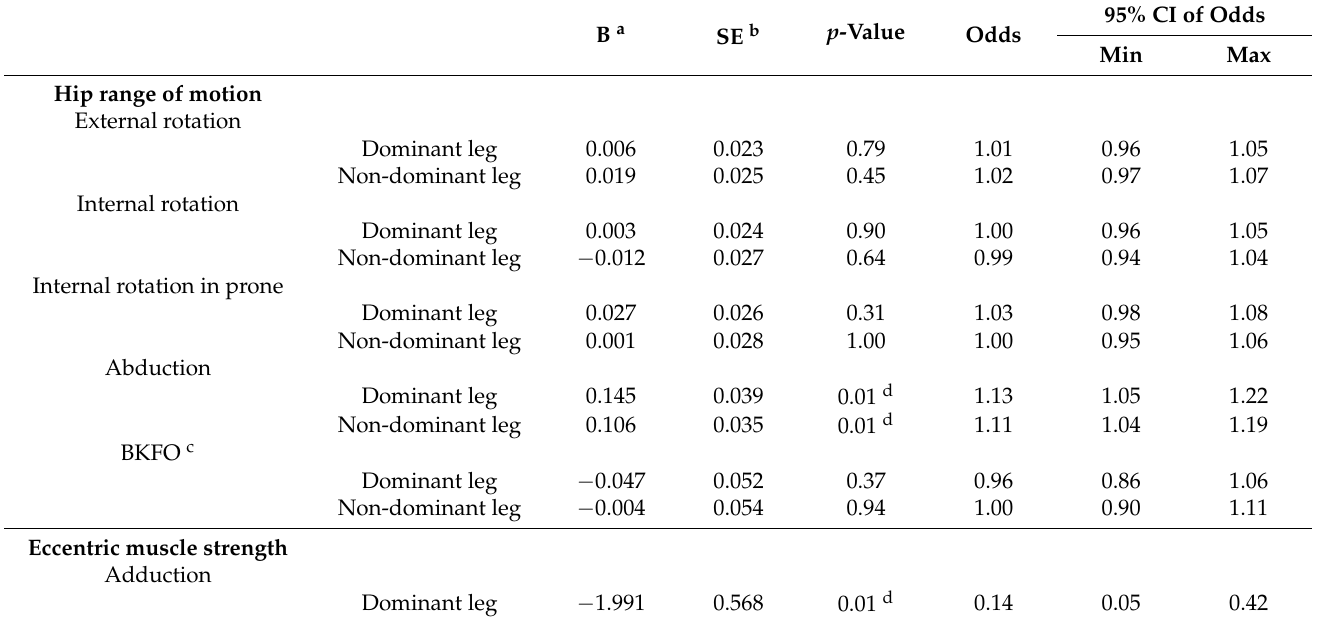
Table 5. Factors related to the development of groin pain (Single logistic regression